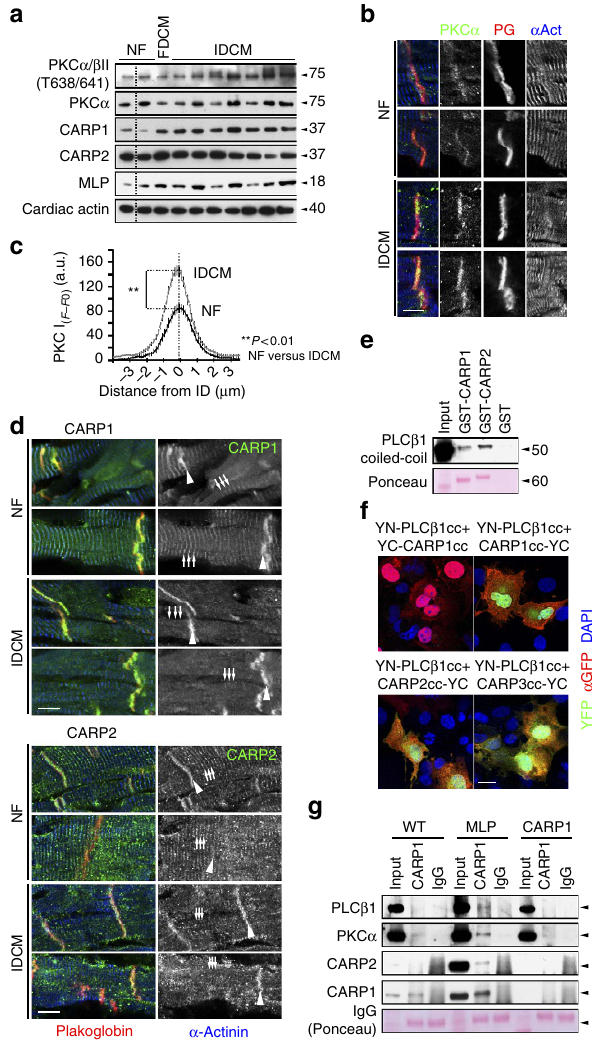
Figure 2 | PKC a is sequestered in a multiprotein complex with CARP at the ID of failing hearts. ( a ) Analysis of PKC a phosphorylation levels (Thr638/641), PKC a , CARP1 and CARP2 protein levels in whole extracts of NF, familial DCM (FDCM) and IDCM patient heart samples. Cardiac actin was used as a loading control. Dotted lines indicate that samples were run on the same gel, but non-consecutive. ( b ) Immunofluorescence staining of human NF and IDCM heart sections using antibodies against PKC a (right, green). Plakoglobin and a -actinin were used as counterstains (red and blue in overlay, respectively). Scale bar ¼ 10 m m. ( c ) Quantification of immunofluorescence intensity ( F (cid:2) F 0 ) over IDs from ( b ) shows that PKC a levels at the ID are increased in IDCM samples compared to NF controls. Sample sizes for analysed ID were n ¼ 24 from three NF heart samples and n ¼ 46 from five IDCM hearts. ( d ) Immunofluorescence staining of human NF and IDCM heart sections using antibodies against CARP1 (top, green in overlay) and CARP2 (bottom; green in overlay). The sarcomeric association (arrows) of CARP1 and CARP2 decreases in IDCM in favour of increased ID localization (arrowheads; for quantification see Supplementary Fig. 1d,e). Plakoglobin and a -actinin were used as counterstains (red and blue in overlay, respectively). Scale bar ¼ 10 m m. ( e ) Pull-down assay of GFP-PLC b 1 (phospholipase-C) with GST-CARP1, GST-CARP2 or GST indicated the coiled-coil domain within PLC b 1 as minimal binding site. Ponceau stain was used to visualize GST-CARP1 and GST-CARP2 protein levels, while equal amounts of GST (not shown) were used as a control. ( f ) Protein complementation assay using YFP (split-fluorescent protein assay) demonstrating antiparallel association (green in overlay) between coiled- coil domains of PLC b 1 tagged on the N-terminus with a YFP N-terminal fragment (YN) and CARP1 tagged on the C-terminus with YFP C-terminal fragment (YC; upper right panel). No association was seen when CARP1 was tagged on the N-terminus with YFP C-terminal fragment (upper left panel). Split-fluorescent protein assay also demonstrated antiparallel association (green in overlay) between coiled-coil domains of PLC b 1 tagged on the N-terminus with a YFP N-terminal fragment (YN) and either CARP2 (lower left panel) or CARP3 (lower right panel) tagged on the C-terminus with YFP C-terminal fragment (YC). Transfection efficiency was validated with a GFP antibody (red in the overlay), and DAPI (blue in overlay) was used as counterstain. Scale bar ¼ 20 m m. ( g ) Co-immunoprecipitation of PLC b 1, PKC a , CARP2 and CARP1 from soluble heart extracts of adult WT, MLP knockout or CARP1 knockout mice by using either CARP1 antibodies or normal rabbit IgG as control (visible in Ponceau